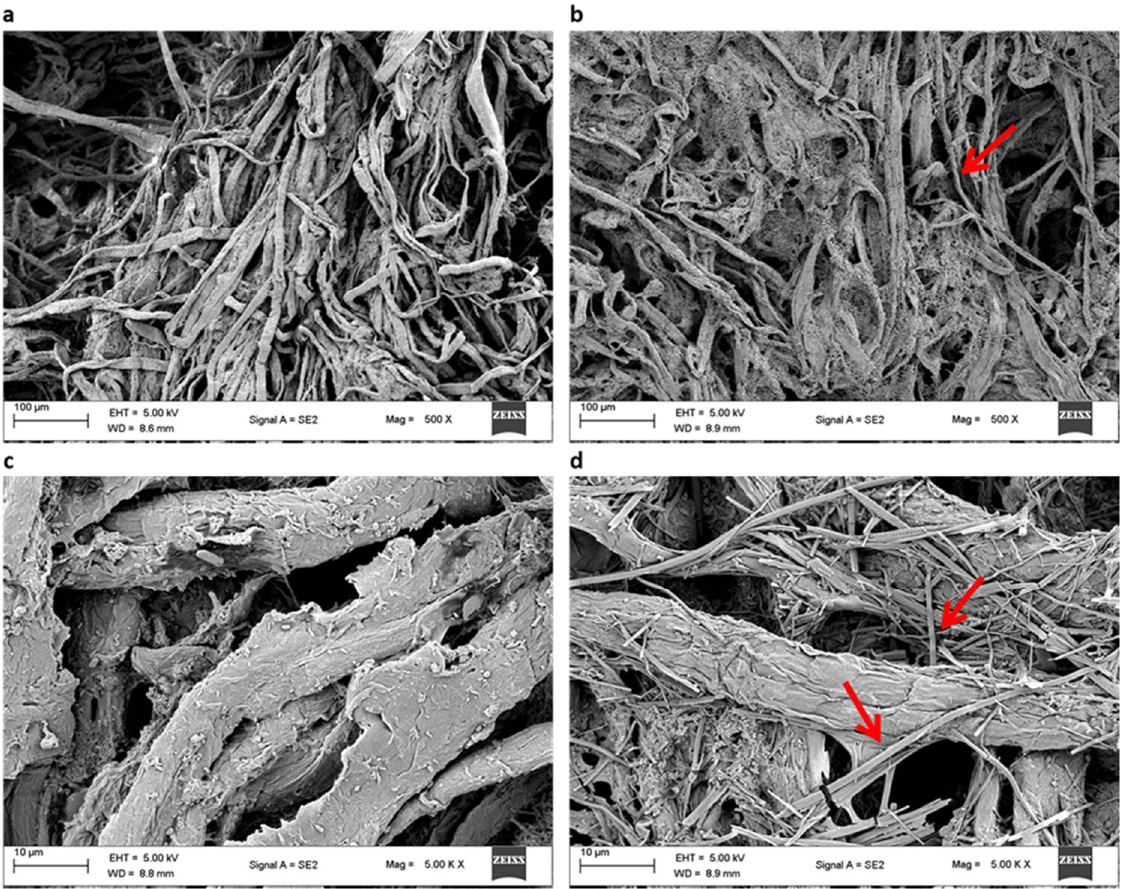
Figure 5. Scanning electron micrographs of ( a ) untreated pulp (500×), ( b ) Beauveria bassiana SAN01 xylanase treated (500×), ( c ) untreated pulp (5000×) and ( d ) Beauveria bassiana SAN01 xylanase treated pulp (5000×). Arrows indicate fibrillation and perforation on the fiber surface.